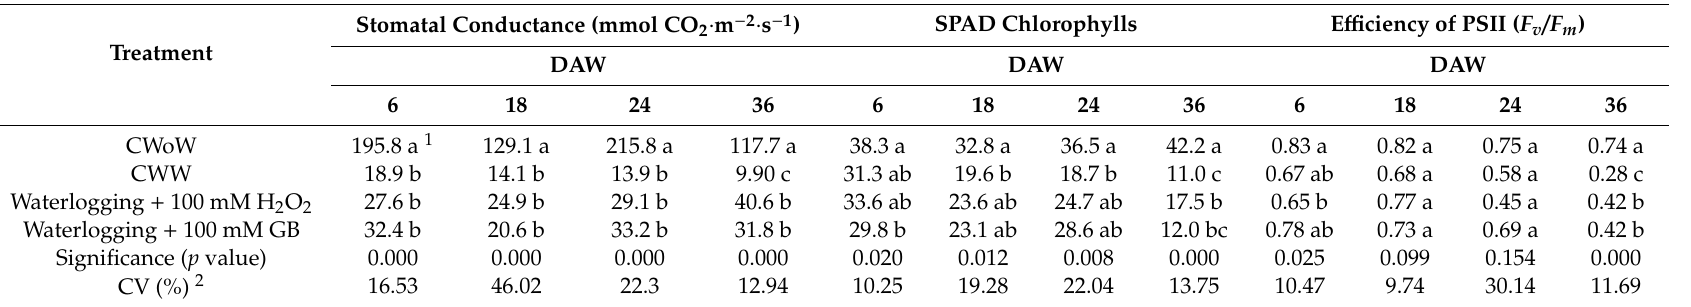
Table 4. Physiological parameters (stomatal conductance, soil plant analysis development (SPAD) chlorophylls, and e ffi ciency of PSII) of Cape gooseberry ( Physalis peruviana L.) plants ecotype Colombia subjected to two waterlogging periods with treatments of control without waterlogging (CWoW), control with waterlogging (CWW), 100 mM of hydrogen peroxide (H 2 O 2 ) and 100 mM of glycine betaine (GB). Evaluated at 6, 18, 24, and 36 days after waterlogging (DAW).